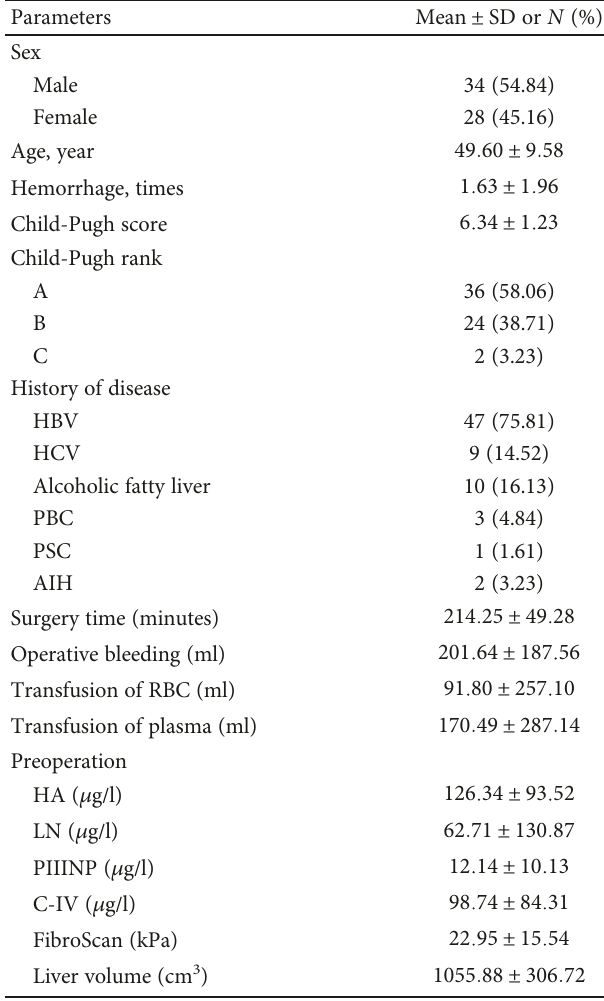
Table 1: Patients ’ demographic and clinical characteristics ( n = 62